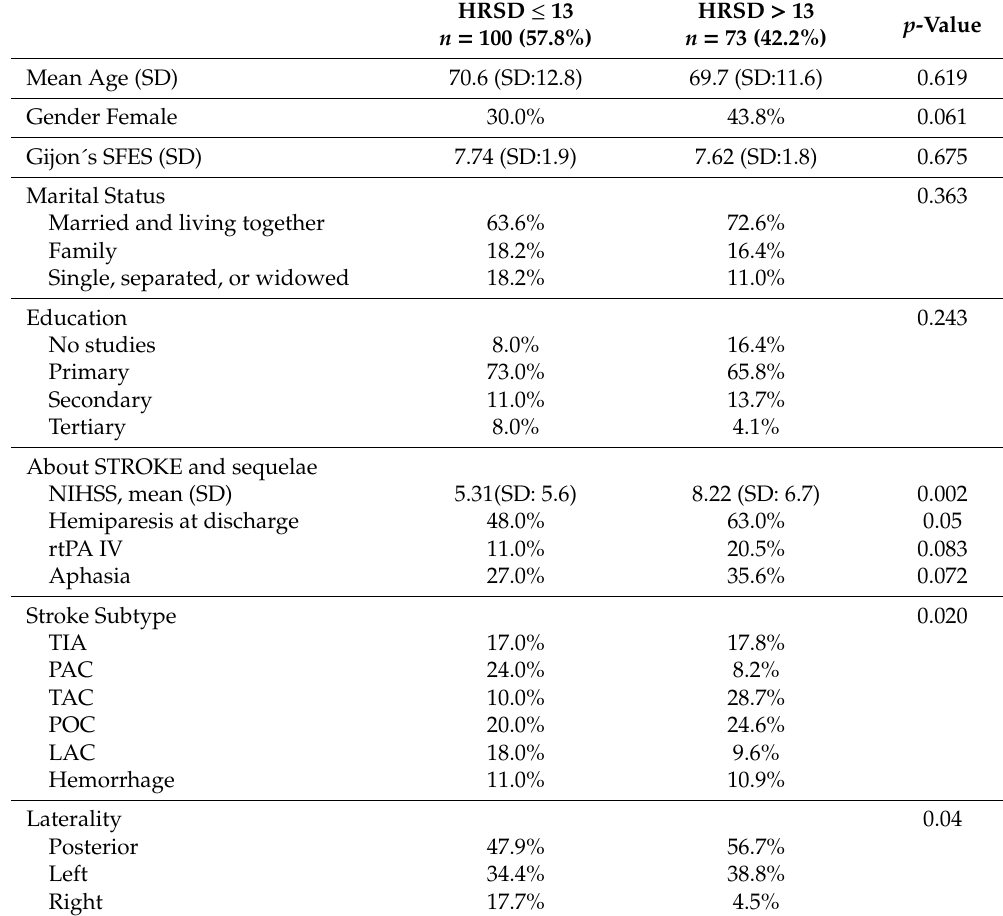
Table 1. Sample characteristics. Univariate